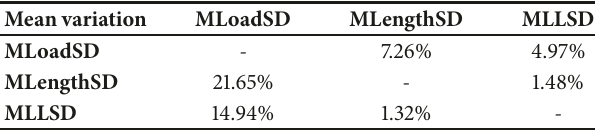
Table 2: Difference in the standard deviation of each method.